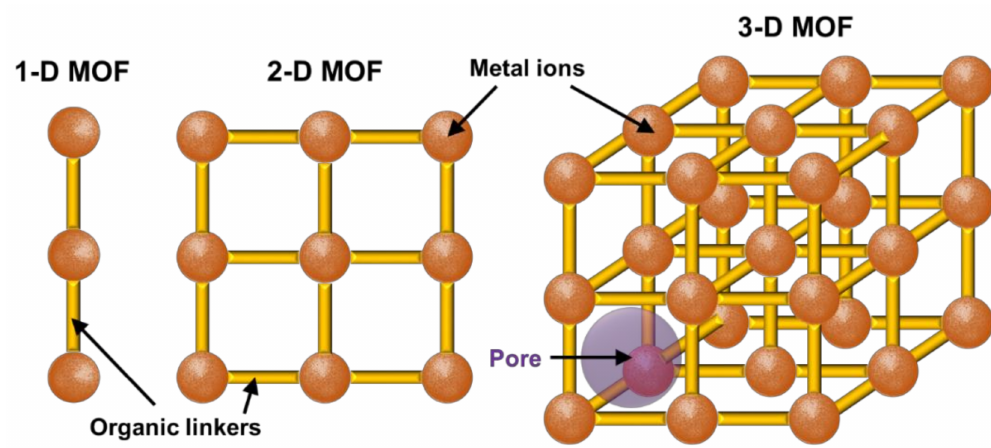
Figure 50. The basic building units of one-, two-, and three-dimensional metal–organic frameworks